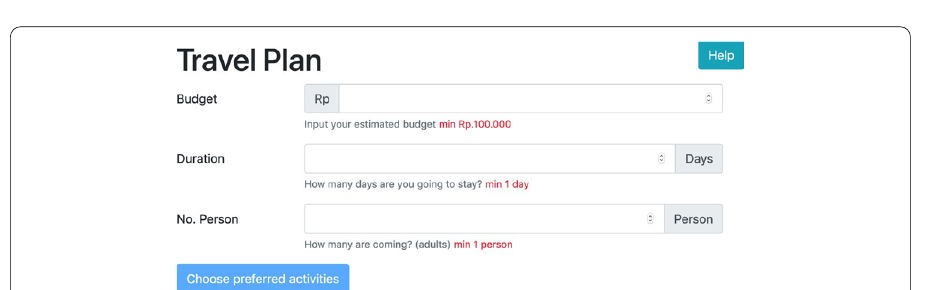
Fig. 3 UI Design for user constraints